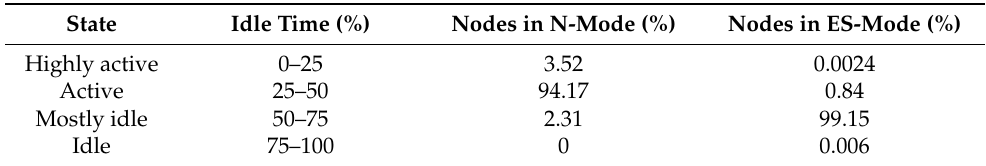
Table 3. Comparison of the number of nodes in an idle state (non-transmit) between the basic (B) and energy-saving (E)